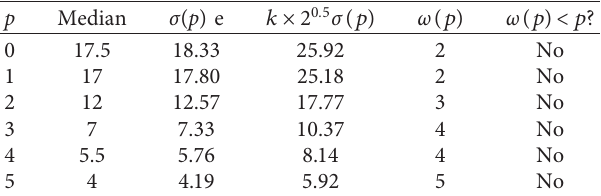
Table 9: One replicate for Example